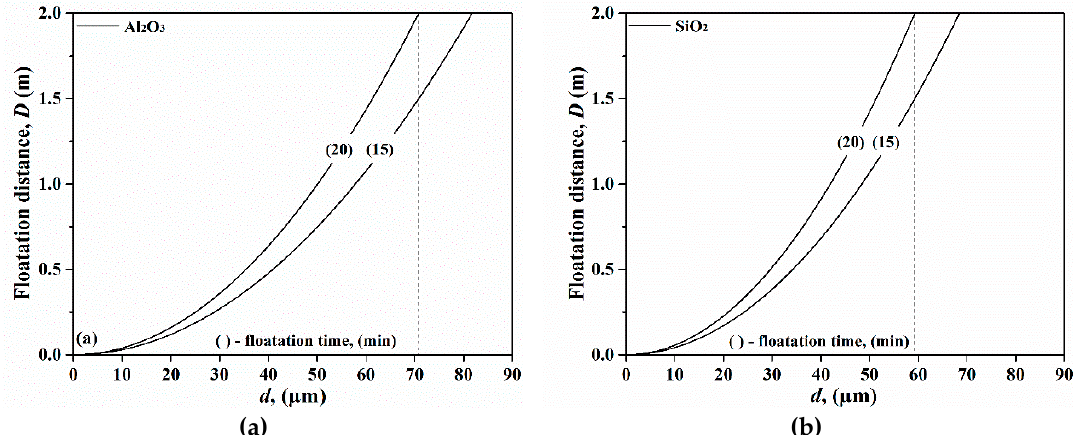
Figure 2. The floatation distances for Al 2 O 3 ( a ) and SiO 2 ( b ) inclusions in liquid steel.